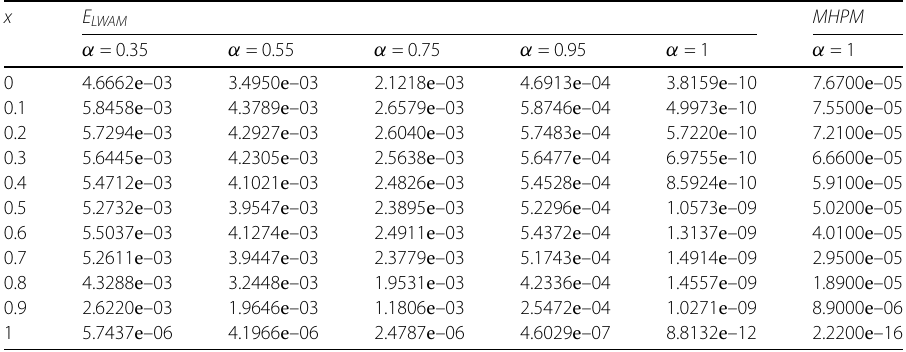
Figure 4 Approximate solution for k = 2, M = 6, α = 1, N = 6 in Example